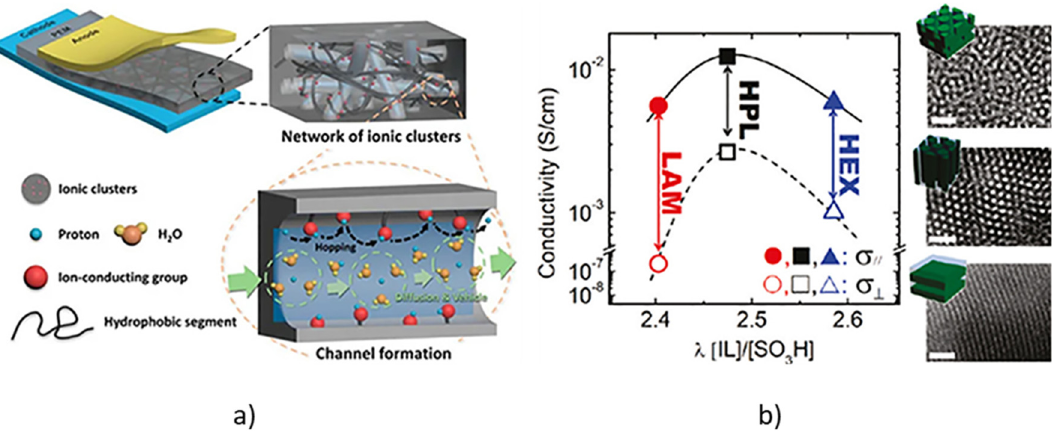
Figure 4. ( a ) Formation of ionic channels induced by interaction of polar groups that favors the proton exchange capacity in fuel cells. ( b ) Different morphologies adopted by the relation of ionic liquids and sulfonic acid groups and its corresponding ionic conductivity. Adapted with permission from reference [76]. Copyright 2021, American Chemical Society.